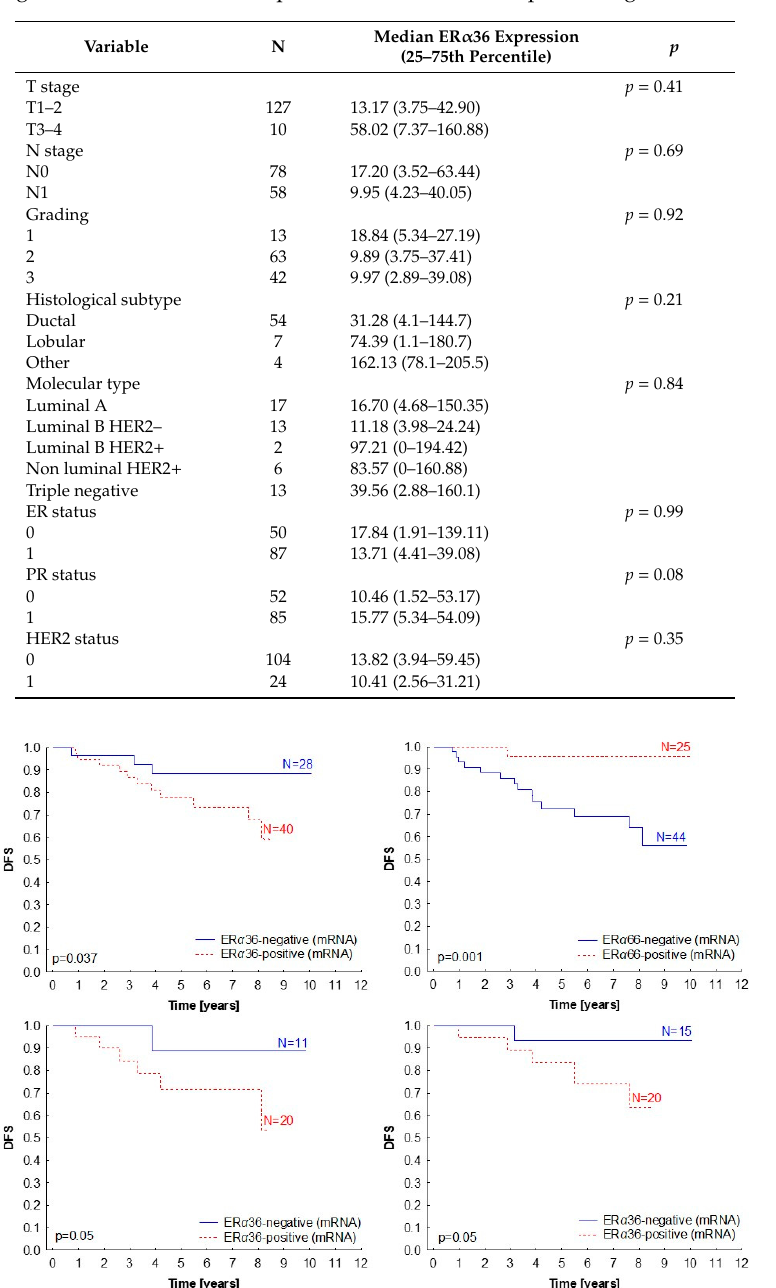
Figure 7. Kaplan–Meier survival curves presenting disease-free survival (DFS) according to ER α 36 ( A ) and ER α 66 ( B ) mRNA levels (measured by qPCR) in primary breast tumors. ( C , D ) Subgroup analysis for ER α 36 expression in ER α 66 protein-negative ( p = 0.05) ( C ) and positive ( D ) patients ( p = 0.05). Median relative gene expression was a cut-o ff value for the classification of samples into negative and